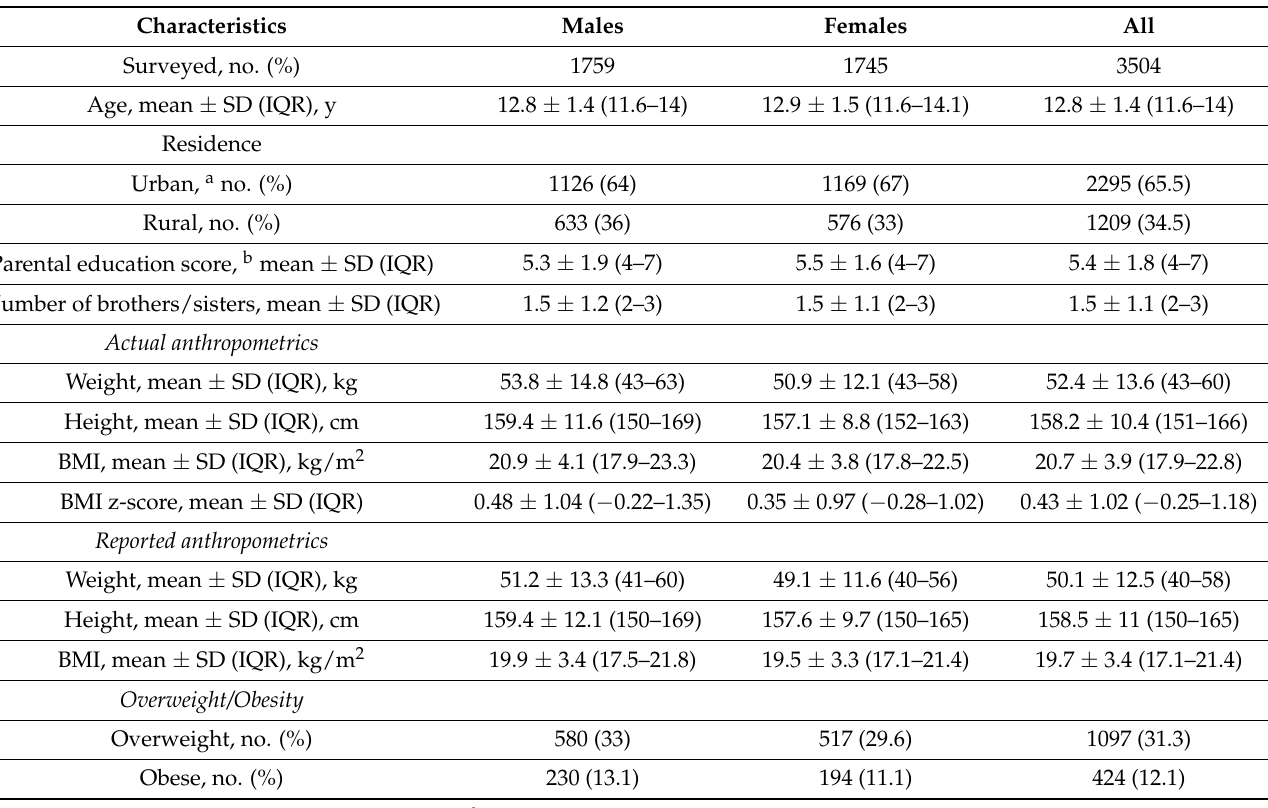
Table 1. Characteristics of the study